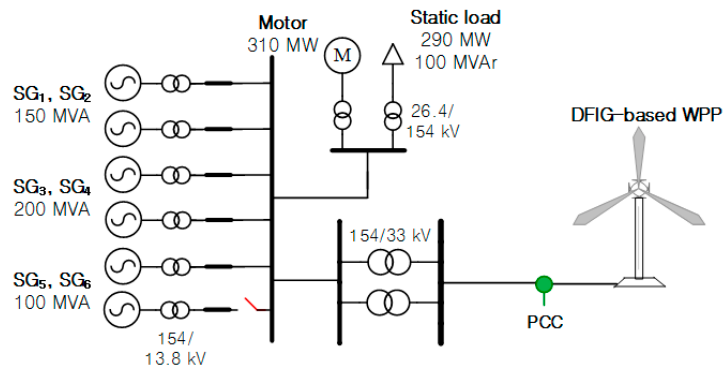
Figure 5. Model system with a DFIG.